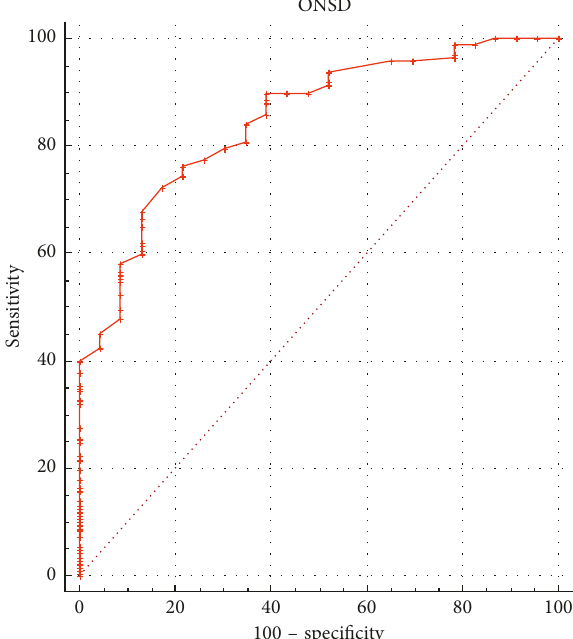
Figure 3: Receiver operating characteristic curve analysis showing the predictive value of the optic nerve sheath diameter (ONSD) measurements for elevated intracranial pressure (ICP; Diagonal segments are produced by